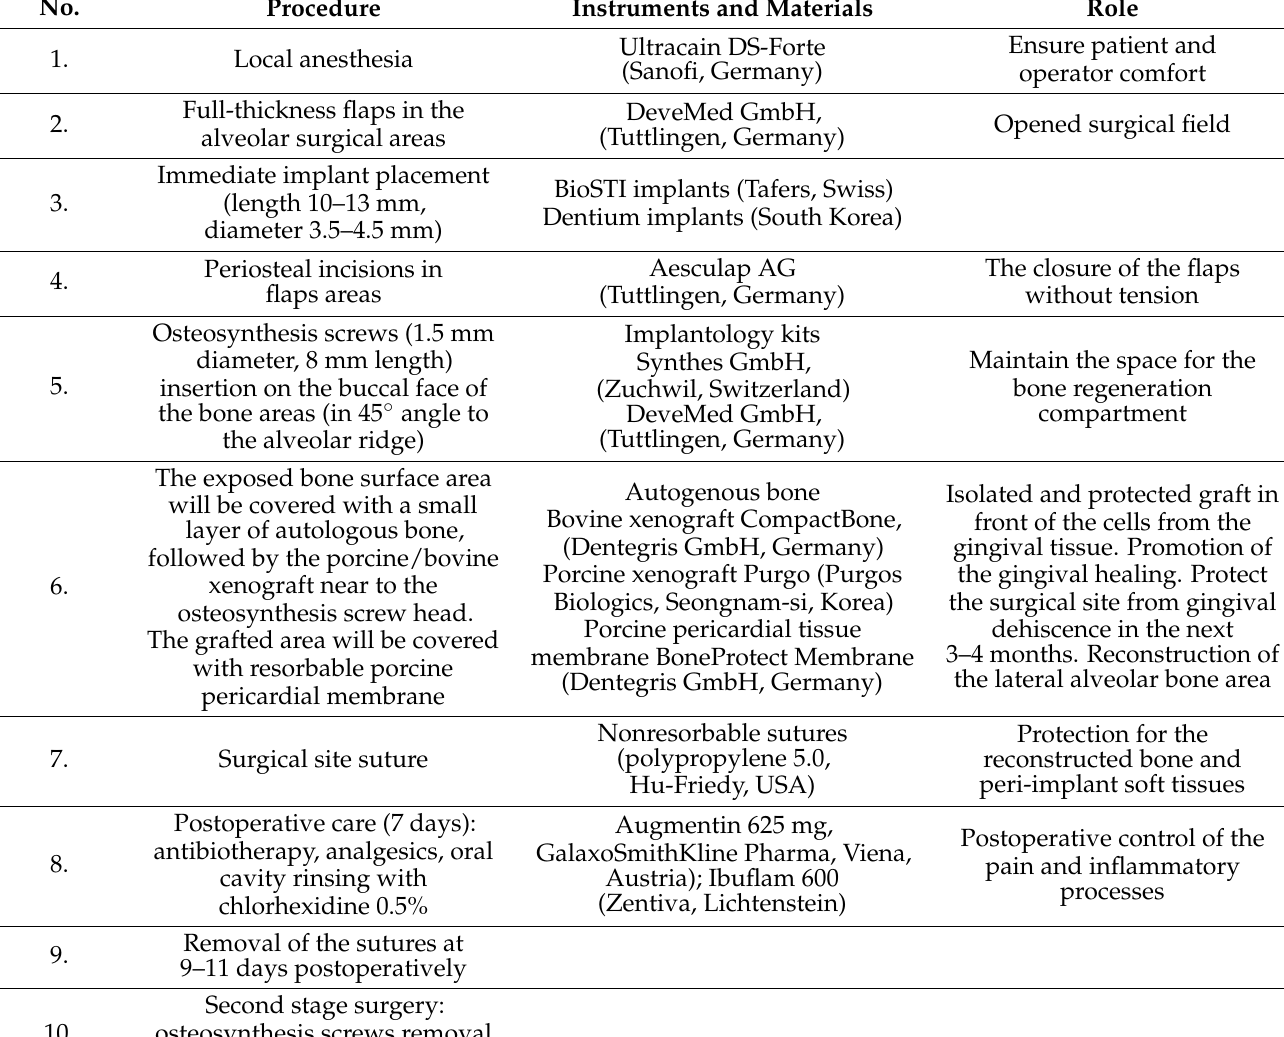
Table 3. Operatory protocol in S-GBR technique and immediate